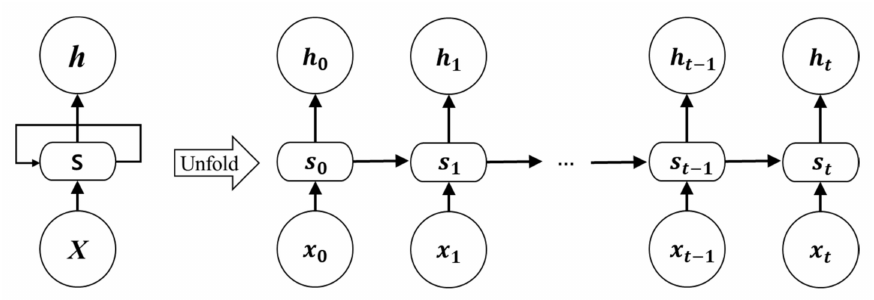
Figure 1. Structure of an RNN.